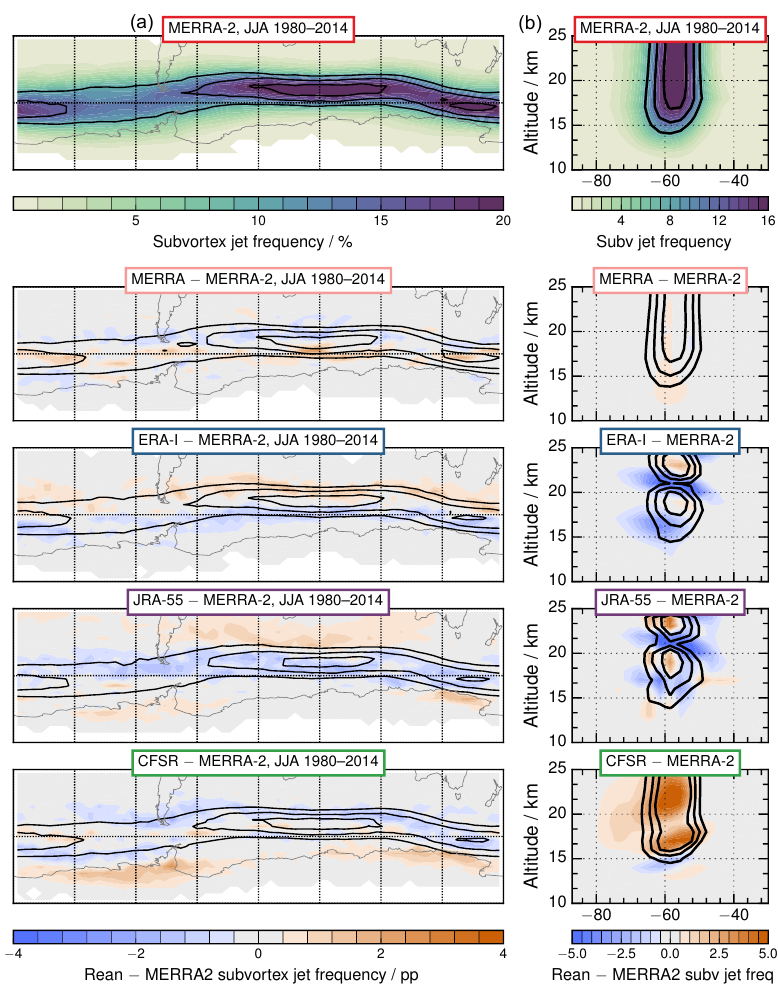
Figure 12. As in Fig. 11, but for maps (a) and cross sections (b) of SH frequency distributions of all subvortex jets in JJA. The latitude domain shown is south of 30 ◦